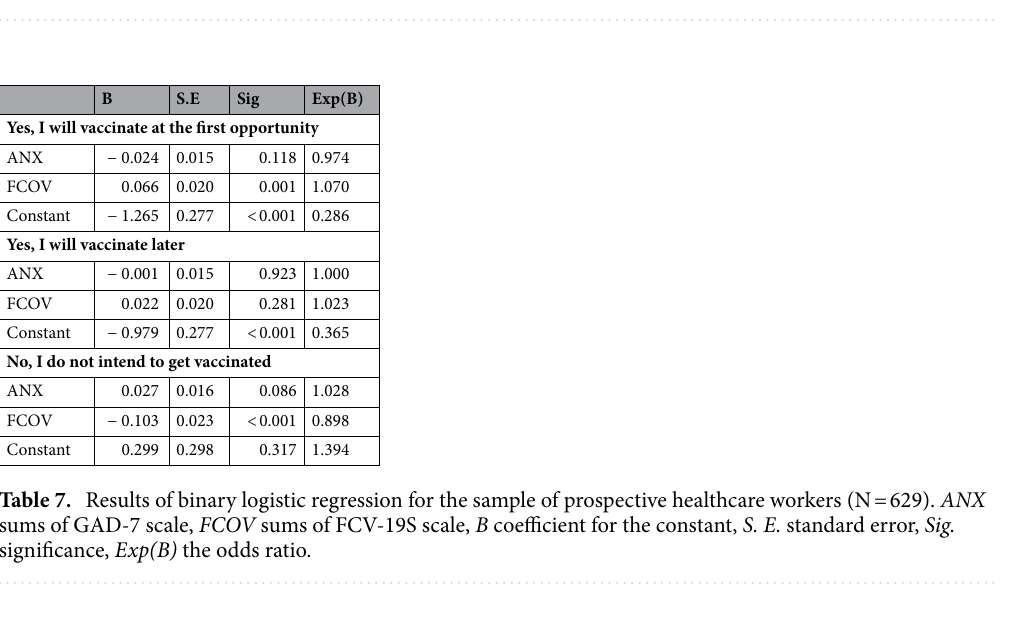
Table 6. Results of binary logistic regression for the sample of medical students (prospective physicians) (N = 510). ANX sums of GAD-7 scale, FCOV sums of FCV-19S scale, B coefficient for the constant. S. E. standard error, Sig. significance, Exp(B) the odds ratio.